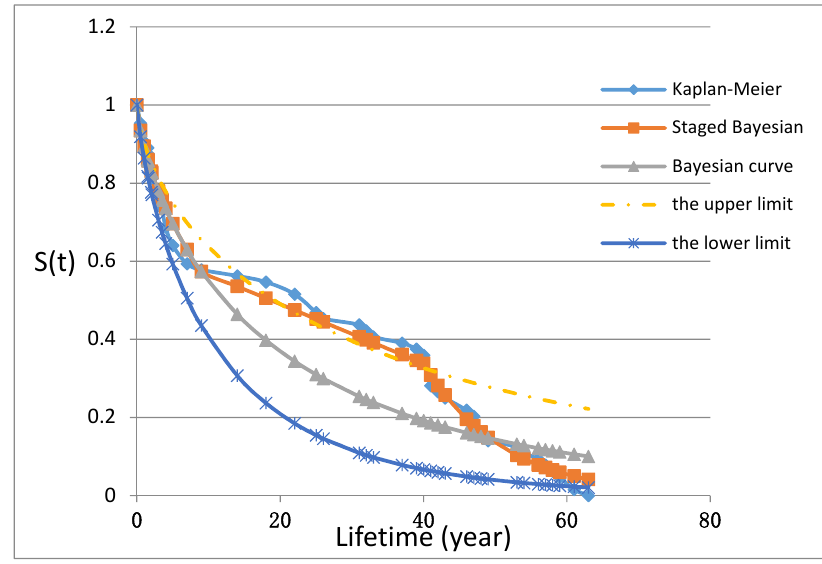
Figure 3. Survival function of girth-weld failure accident. Table 1. Survival function parameter of different stages.